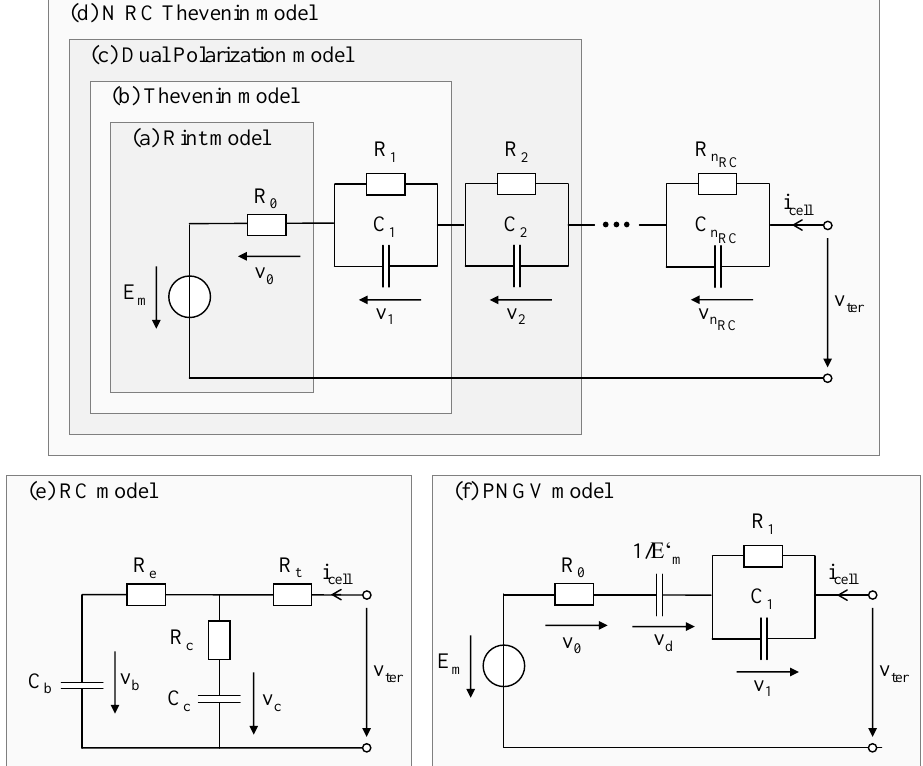
Figure 3. Typical equivalent electrical circuit models used for vehicle batteries: ( a ) Rint model; ( b ) Thevenin model; ( c ) Dual Polarization model; ( d ) N RC Thevenin model; ( e ) RC model; and ( f ) PNGV model. From [99] with permission from Elsevier, Copyright